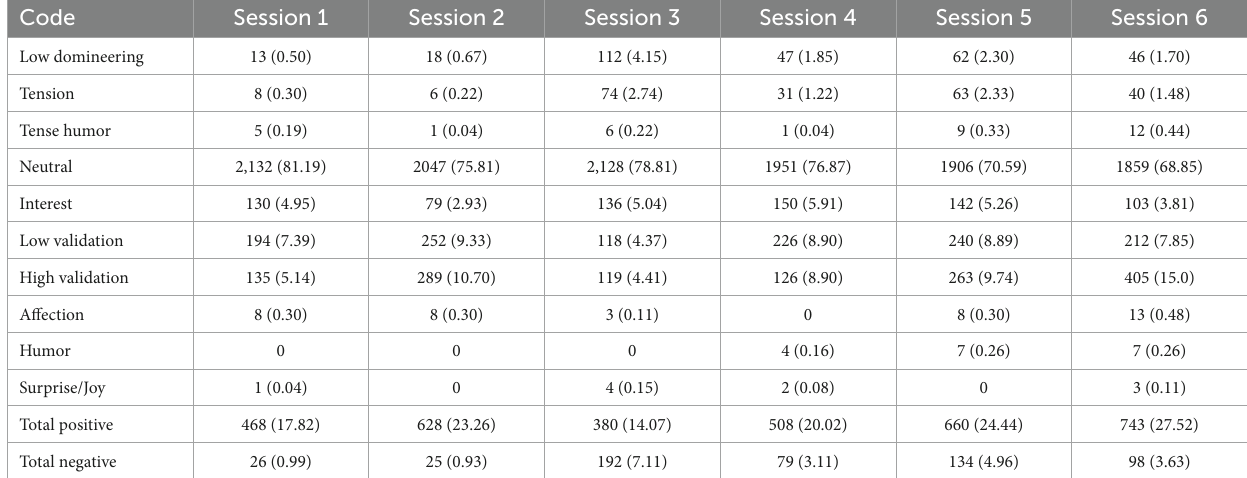
TABLE 1 SPAFF codes for Dr. Jon Carlson over six